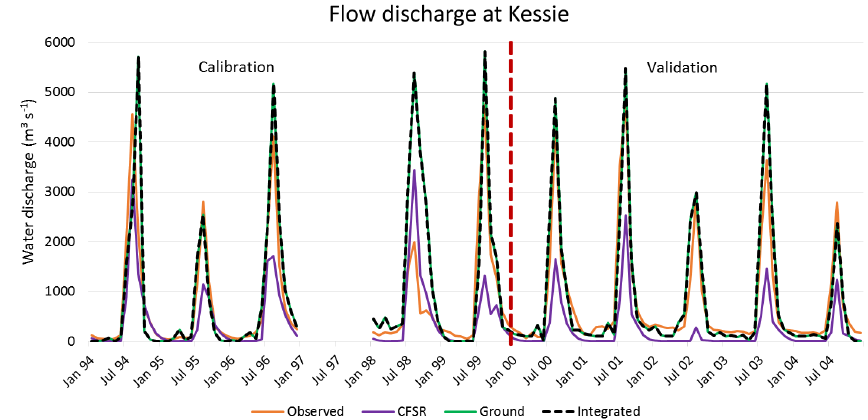
Figure 9. Calibration and validation of SWAT30 at Kessie. Calibration results achieved R 2 and NS values of integrated data: 0.74, 0.74; ground data: 0.74, 0.72; and CFSR data: 0.87, 0.46, respectively. Validations results achieved R 2 and NS values of integrated data: 0.76, 0.74; ground data: 0.78, 0.74; and CFSR data: 0.86, 0.49, respectively.